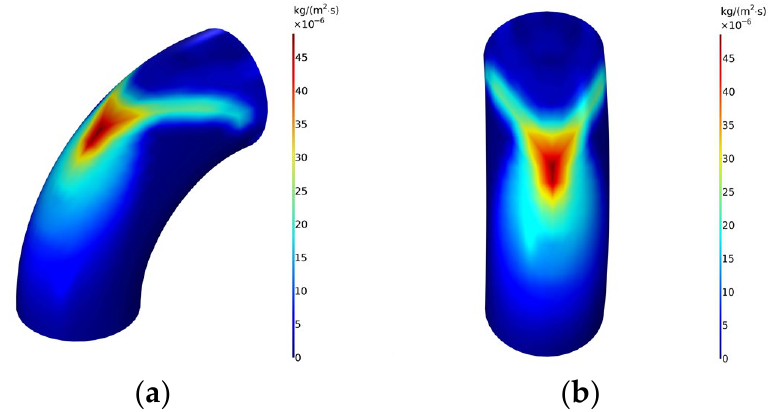
Figure 3. Comparison of erosion rate distribution at the elbow.